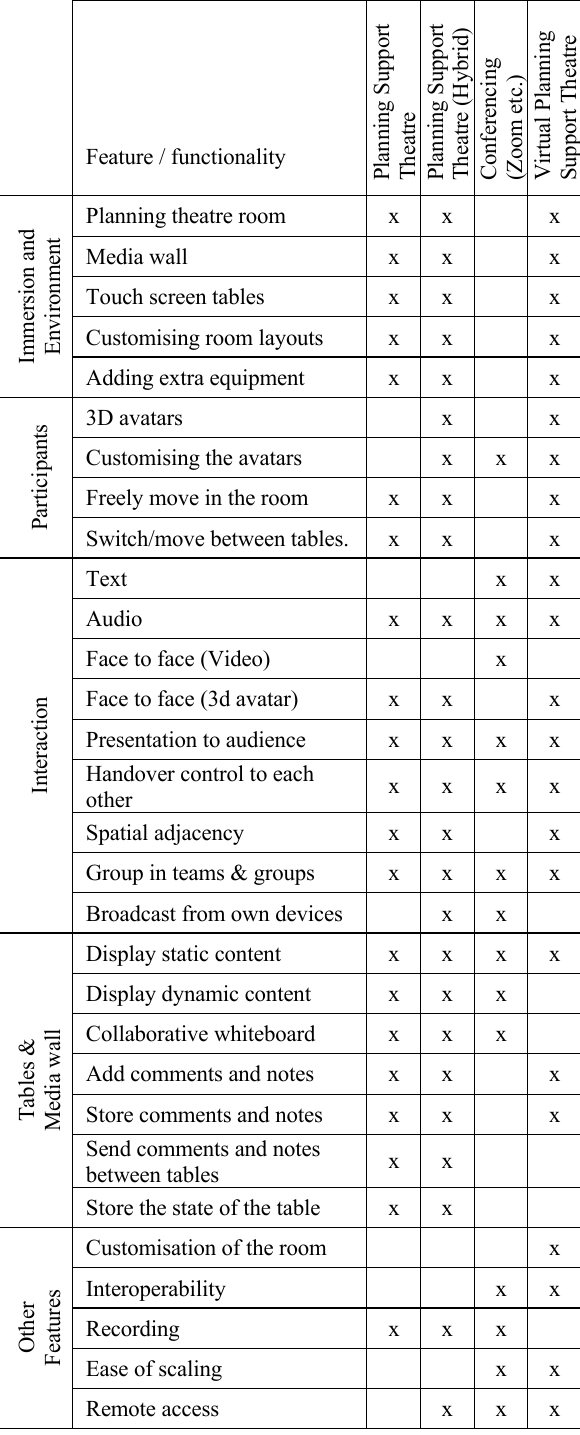
Table 1: A comparison of features of various forms of PSTs with the virtual